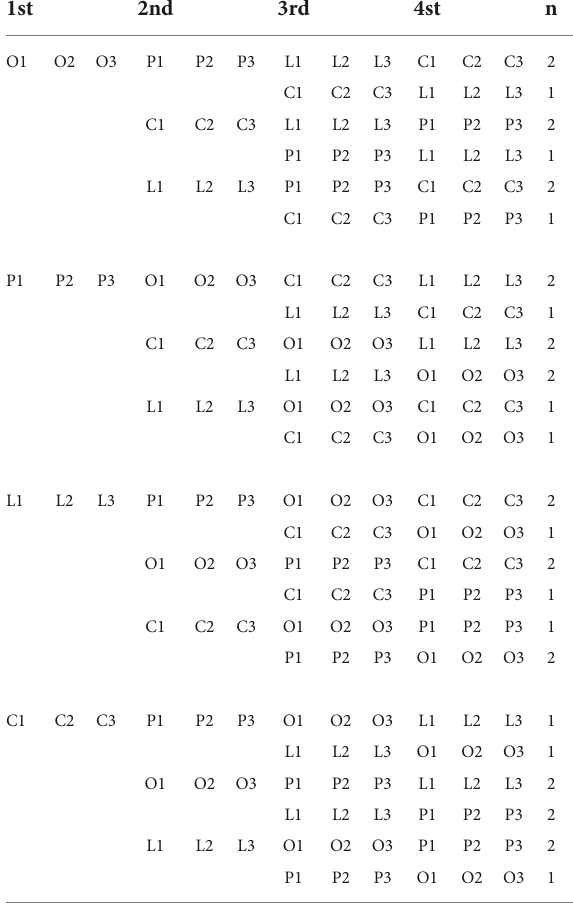
TABLE 2 Ethogram of behaviors recorded during testing. Behavior